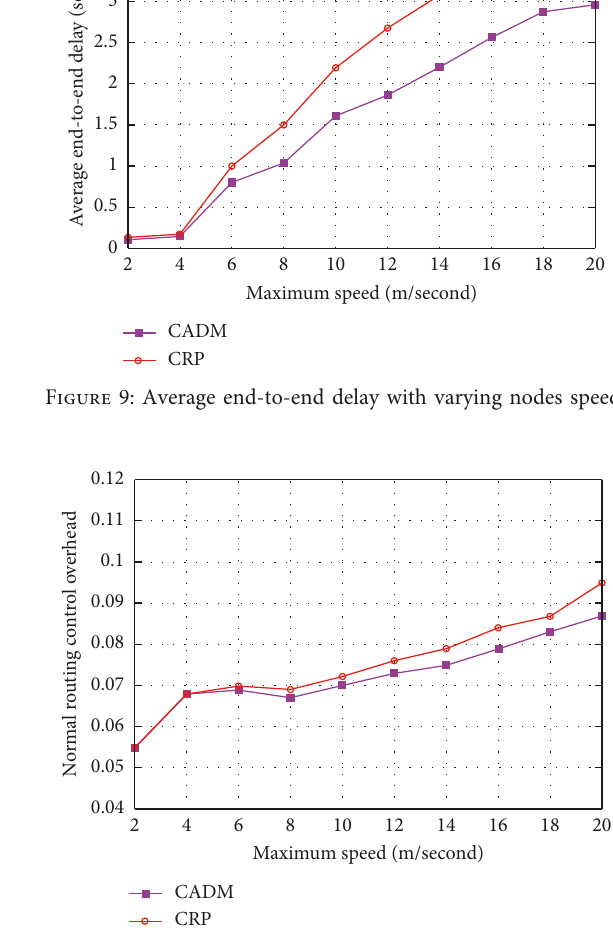
Figure 10: Normalized control overhead with varying nodes speed.